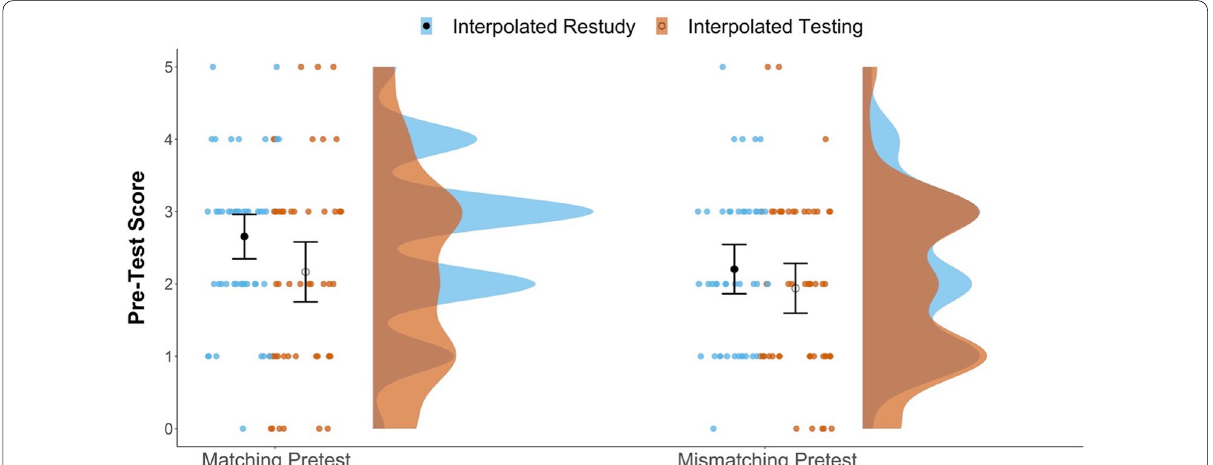
Fig. 2 Raincloud plots depicting differences in pretest scores between conditions. Dots represent individual subject means in each condition. The closed black dots represent group-level mean estimates for the Restudy conditions; open circles represent the group-level mean estimates for the Testing conditions. Error bars are 95% confidence